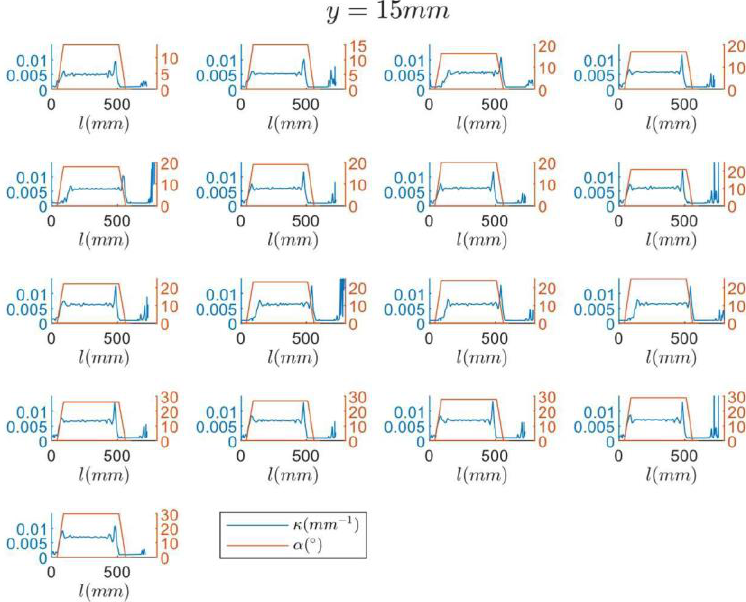
Figure 2. Resulting curvature 𝜅 out of the combinations depicted in the last row of Table 1.